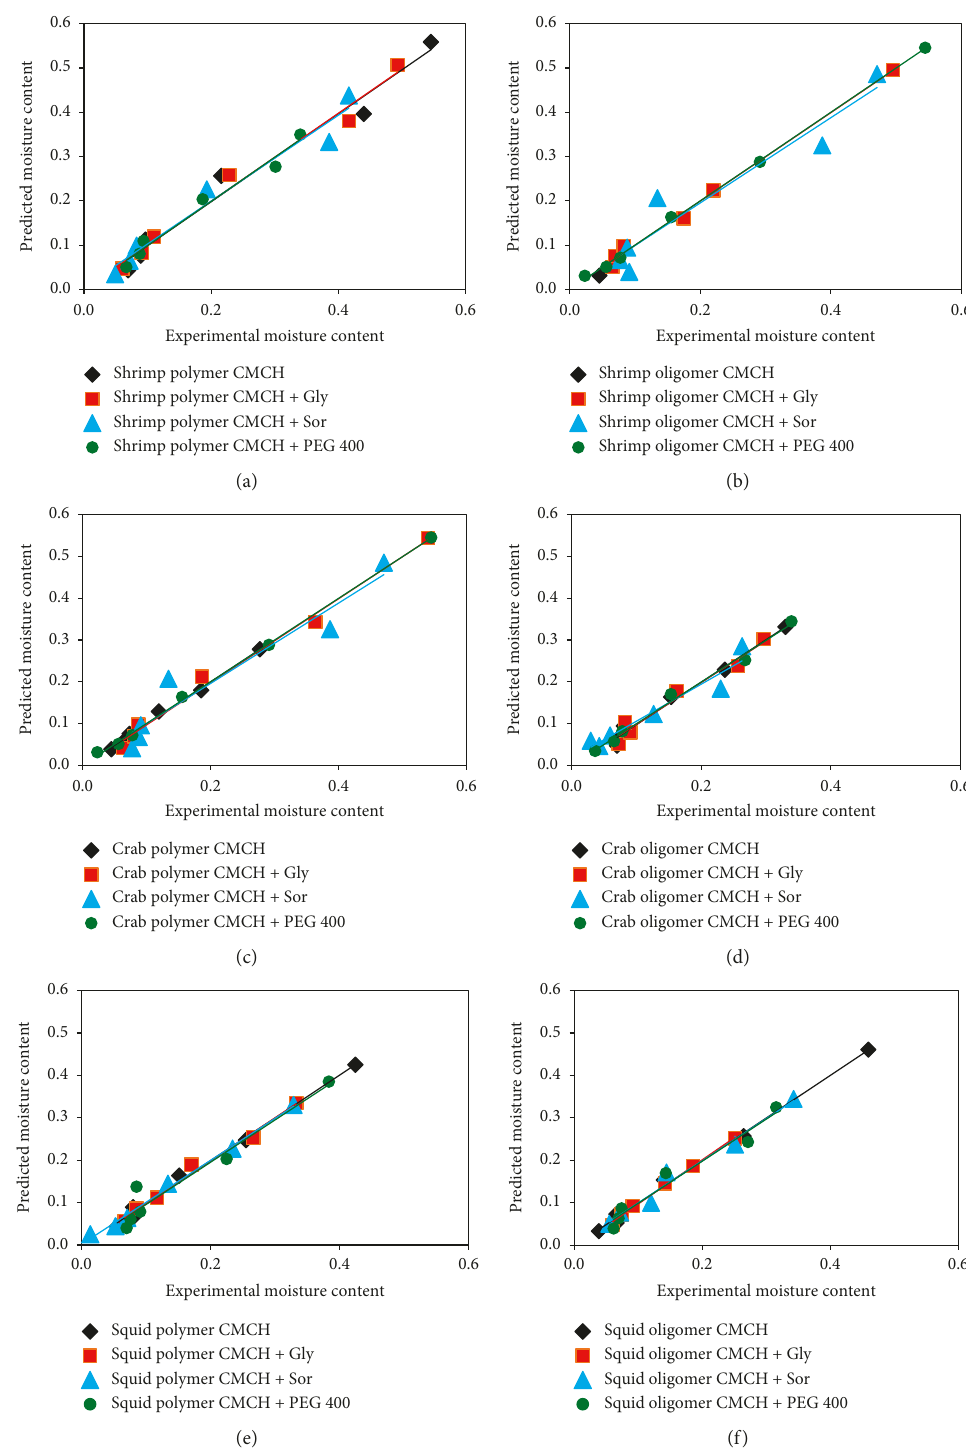
Figure 10: The comparison between the experimental moisture content values and those predicted for all the CMCH films from the GAB model: shrimp polymer CMCH films (a); shrimp oligomer CMCH films (b); crab polymer CMCH films (c); crab oligomer CMCH films (d); squid polymer CMCH films (e); squid oligomer CMCH films